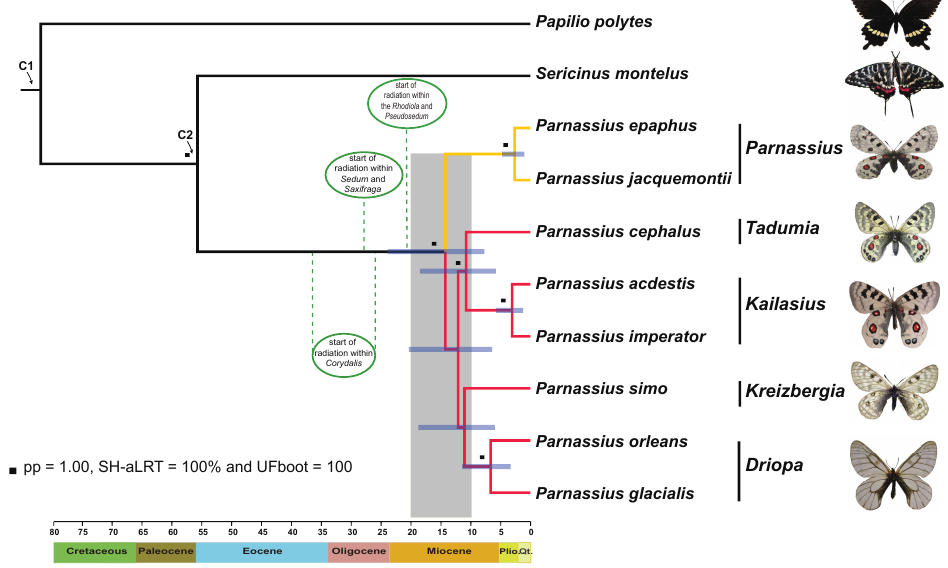
Figure 1. Phylogenetic relationships and divergence time estimates of the genus Parnassius based on amino acids of 476 orthologous genes. The tree was inferred under the maximum likelihood and Bayesian analyses. Divergence times were estimated under the birth-death prior shown with the 95% confidence intervals (blue bars); C1 and C2 show the time calibration points; the border in gray shows the time range (10–20 Ma) of the progressive extension of the uplift of the Qinghai–Tibet Plateau (QTP) and related environmental changes. Lineages in yellow and in red mostly feed on the hostplants Crassulaceae + Saxifragaceae (e.g., Sedum , Rhodiola , Pseudosedum and Saxifraga ) and Papaveraceae (e.g., Corydalis ),